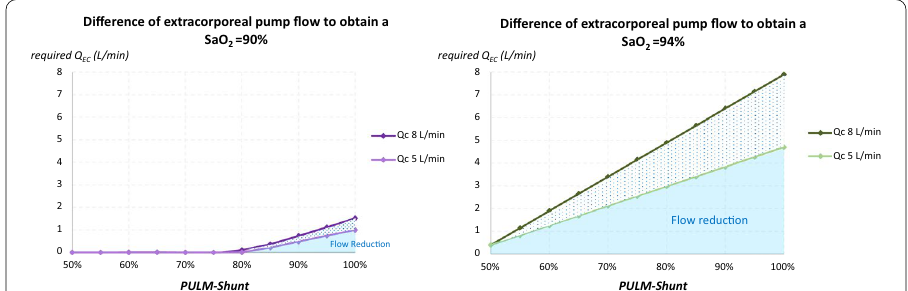
Fig. 5 Reduction in required Q EC from the IVC cava, PULM-Shunt pulmonary shunt, Q EC extracorporeal pump flow, Q C cardiac output, RA right atrium, SaO 2 arterial blood oxygen saturation, SVC superior vena